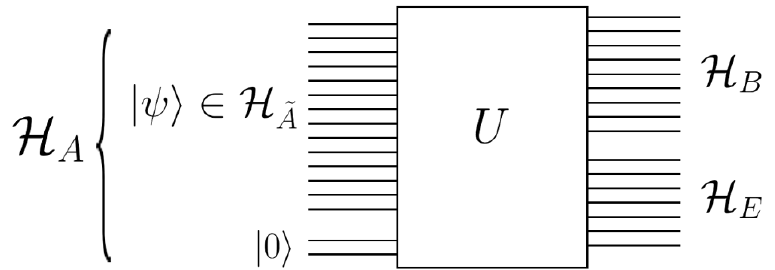
Figure 2 . Alice has a quantum state j i 2 H ~ a few qubits in a (cid:12)xed state j 0 i (embedding H ~